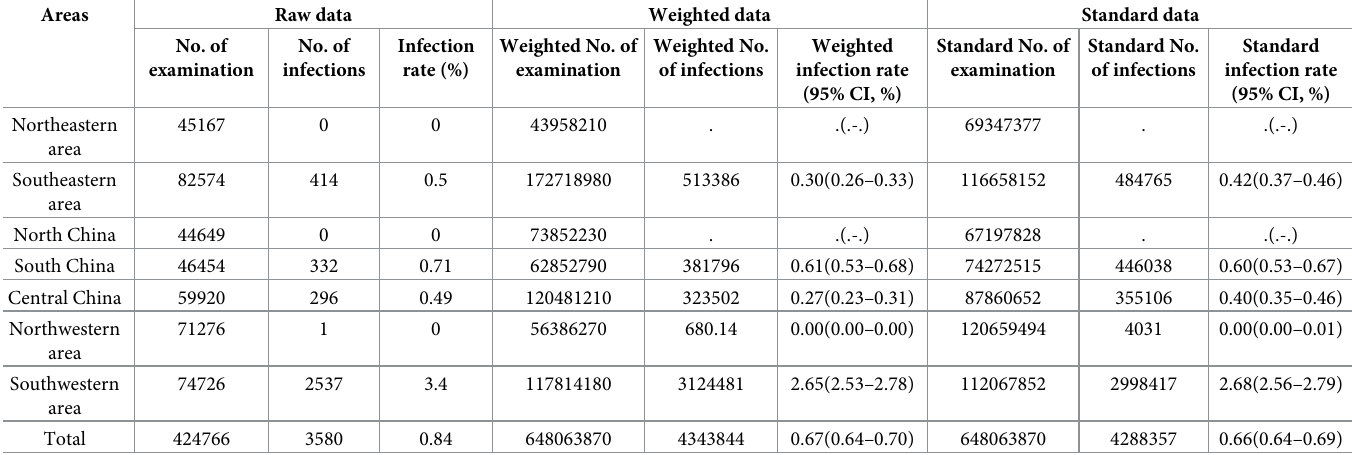
Table 2. Distribution of hookworm infections in different areas in 2019 according to the national surveillance. Areas Raw